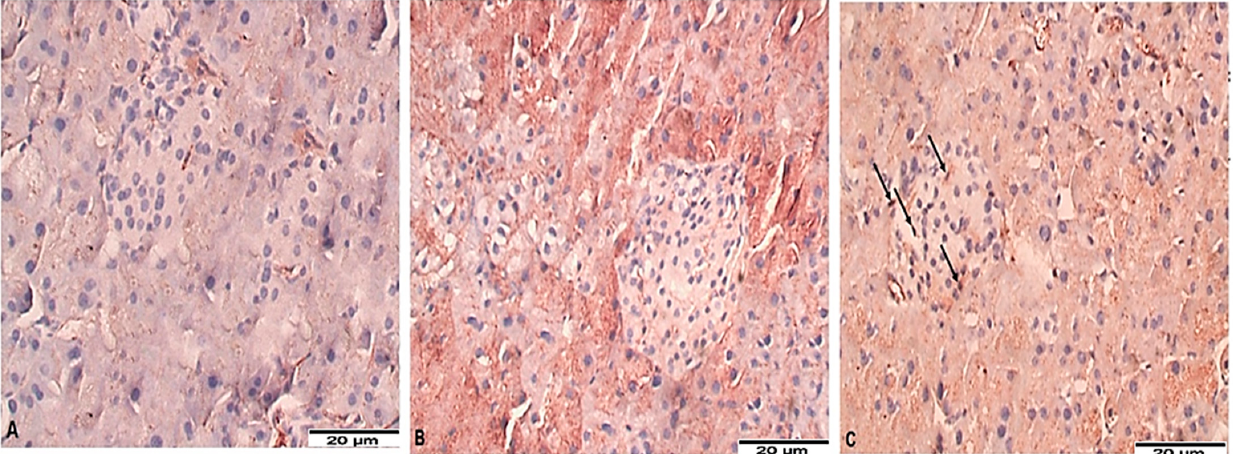
Figure 2. CD8 + T cells Infiltrated pancreatic islets of Langerhans of mice with chronic toxoplasmosis. Immunohistochemistry representative images of pancreatic tissue sections stained for CD8 showing absence of CD8 + T cell infiltration into islets of Langerhans of uninfected ( A ) and acute toxoplasmosis mice ( B ) but marked infiltration of CD8 + T cells into islets of Langerhans of chronic toxoplasmosis mice group ( C ).